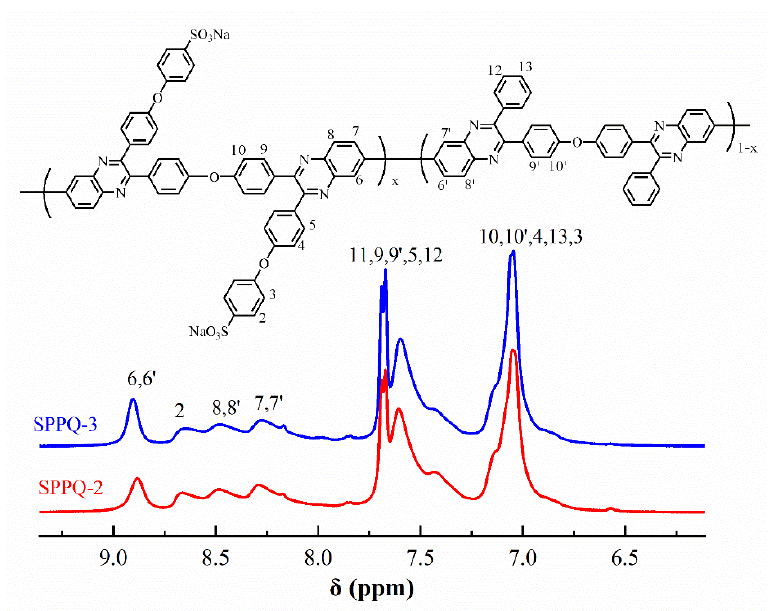
Figure 6 . 1 H-NMR spectra of SPPQs.